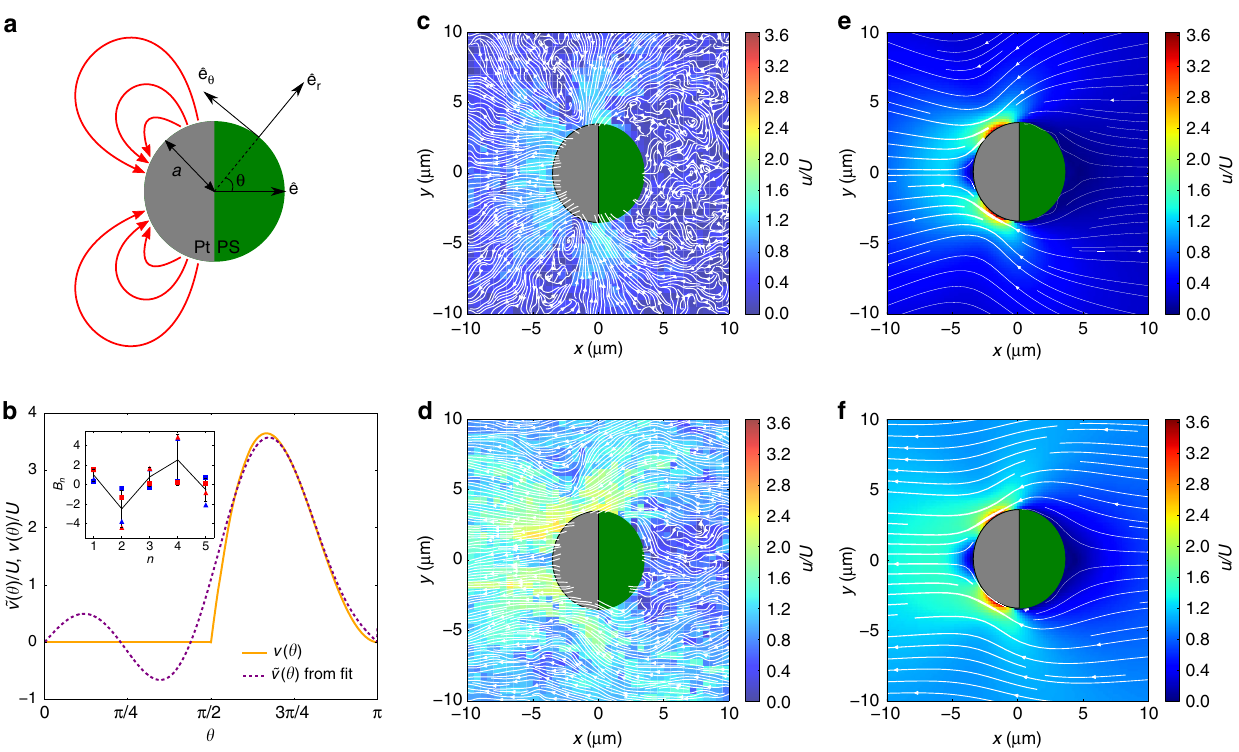
Fig. 1 Experimental measurements of the fl ow fi eld around an active Janus sphere. (a) Sketch of the Pt-PS Janus particle and notations. ^ e is the direction of swimming. The red arrows represent the current loops that start at the equator of the particle and end at its pole 13,16,17 . (b) Inset: First fi ve coef fi cients in the expansion of v ( θ ) in Legendre polynomials, obtained as fi tting parameters of the experimental radial and tangential velocities, in the cases where the colloid is stuck or freely moving (blue: stuck, red: moving; triangle: radial, square: tangential). The averages are shown as black dots, and the error bars correspond to the standard deviations. Main: Plot of the slip velocity ~ v ð θ Þ reconstructed from the averages of the Legendre coef fi cients obtained from the fi t (dashed) compared with the simpli fi ed expression for v ( θ ) we use for further analysis. ( c – f ) Streamlines around the Janus particles obtained experimentally ( c , d ) and analytically ( e , f ), in the two situations where the particle is stuck ( c , e ) and freely moving ( d , f ). The background colours represent the magnitude of the velocity u ¼ j u j rescaled by the swimming velocity of the Janus particle when it is freely